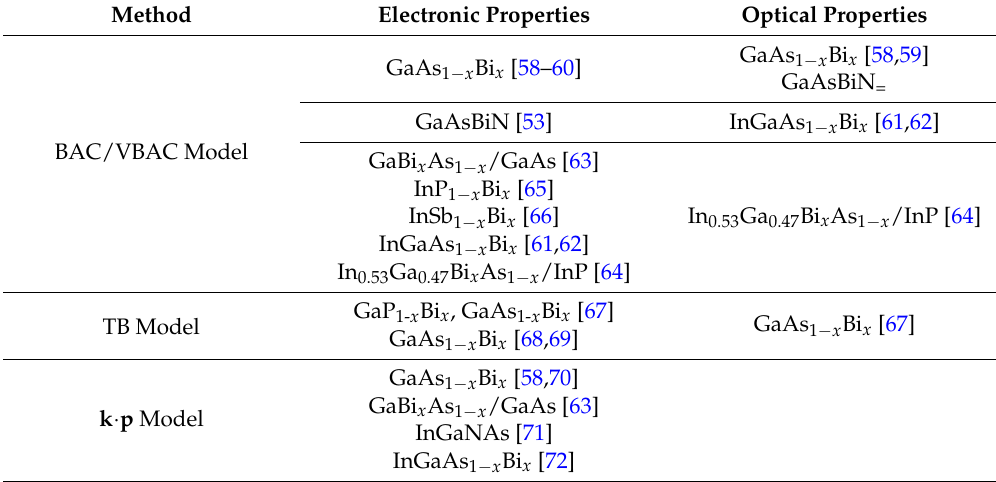
Table 1. Summary of the empirical models and their usages in Bi-containing III-V